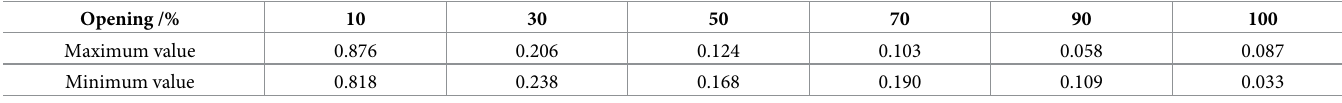
Table 2. The extreme values of the lift coefficient at different